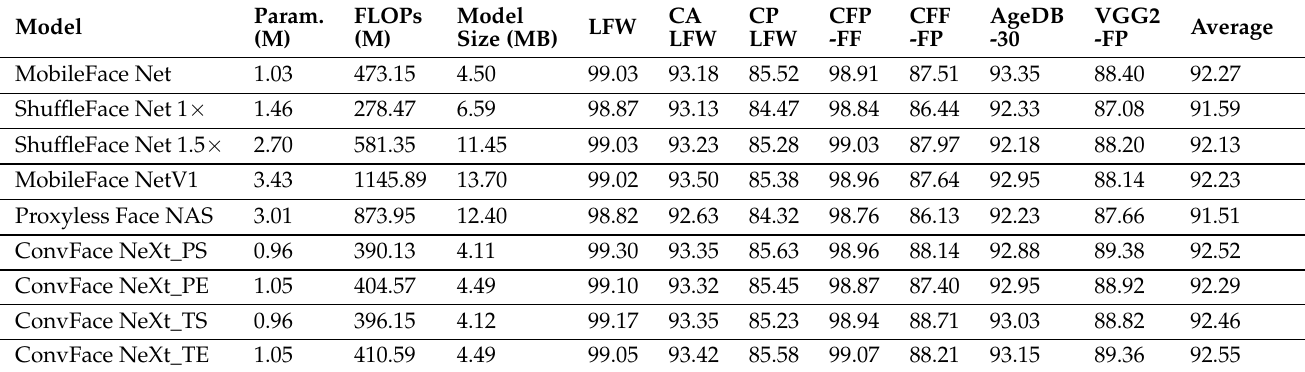
Table 10. Performance results of different models. These results are reported in terms of parameters, FLOPs, model size and verification accuracy for LFW, CALFW, CPLFW, CFP-FF, CFP-FP, AgeDB-30 and VGG-2FP. Aside from that, the average accuracy for the seven image-based datasets is shown in the last column.